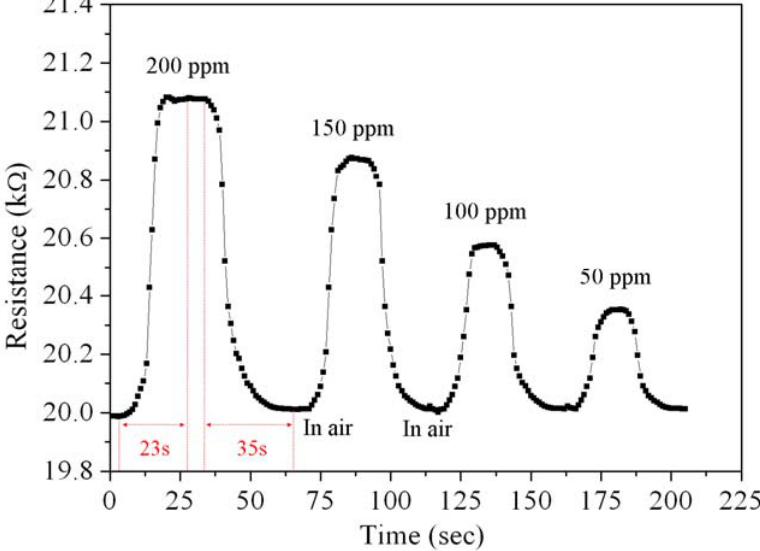
Figure 11. Relation between the resistance variation and CO concentration for the CO sensor.